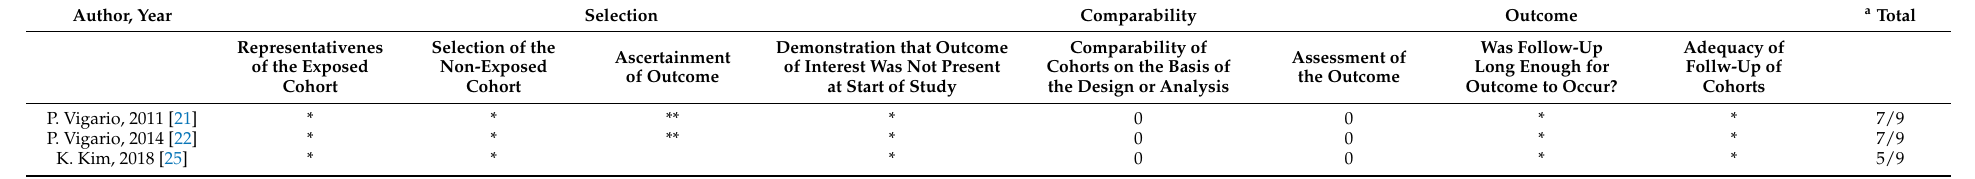
Table 2. Qualitative evaluation of prospective studies according to the Newcastle–Ottawa scale.